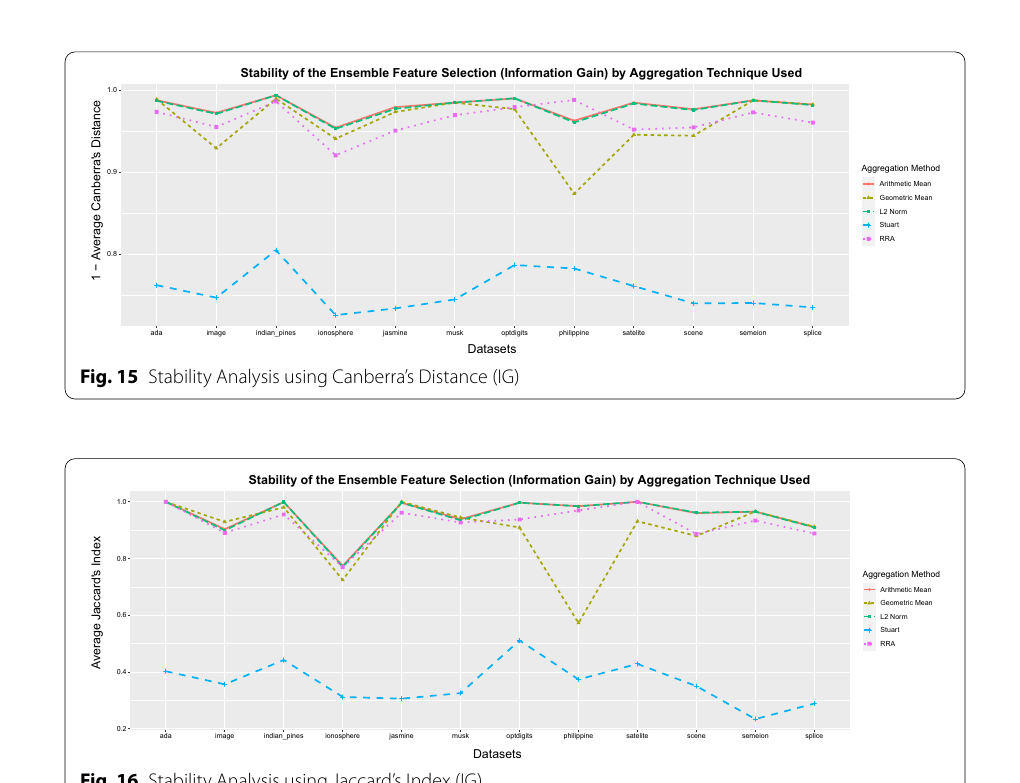
Fig. 14 Semeion dataset classification results